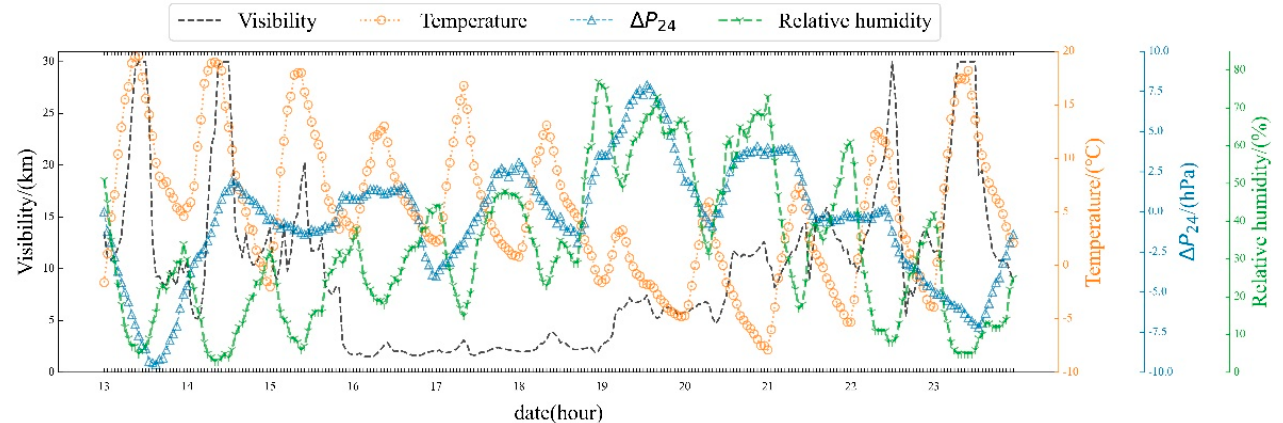
Figure 7. Cluster analysis of HYSPLIT backward trajectory in Xining City during March 2021.